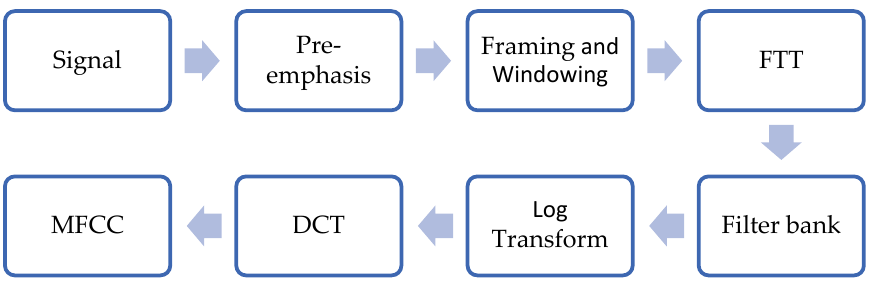
Figure 1. The MFCC feature extraction process, where FFT is the Fast Fourier Transform, and DCT is Discrete Cosine Transform.